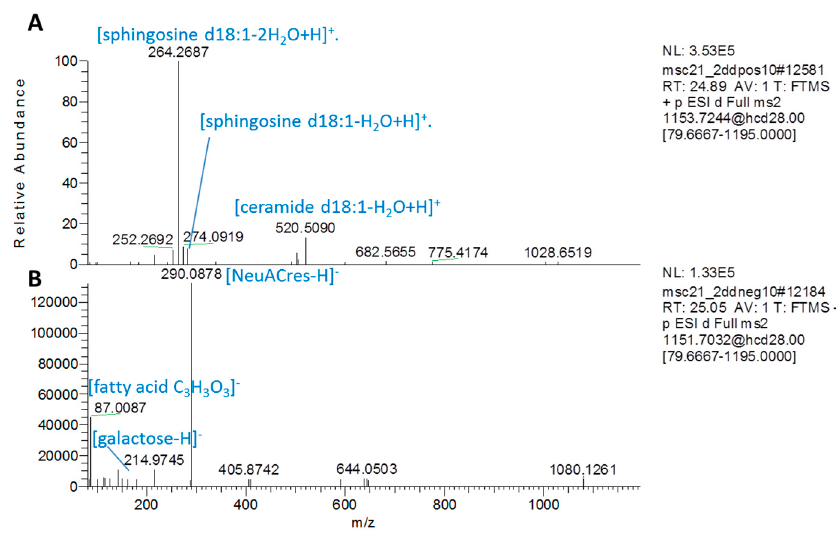
Figure A7. MS2 spectra of predicted ganglioside. Fragmentation spectra (Thermo Xcalibur) of regulated ganglioside GM3(d18:1/16:0) (sum formula, C 57 H 104 N 2 O 21 ) show characteristic